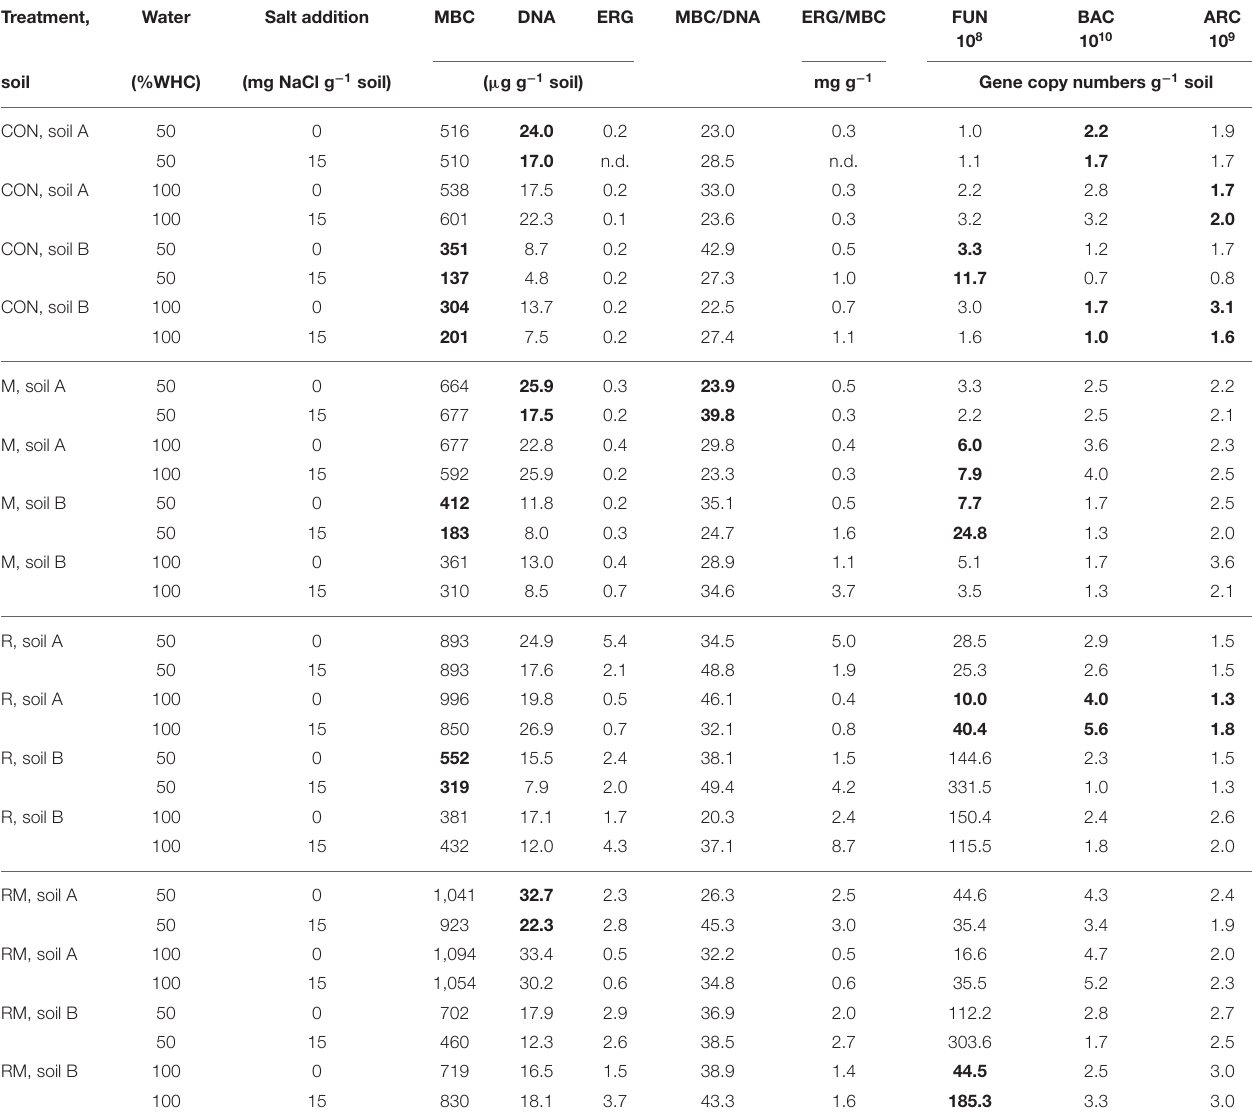
TABLE 2 | Microbial biomass C (MBC), total extractable DNA, ergosterol (ERG), the MBC/DNA ratio, the ERG/MBC ratio, fungal ITS1 sequences g − 1 soil (FUN), bacterial (BAC) and archaeal (ARC) 16S rRNA gene copies g − 1 soil in control (CON), manure (M), rice straw (R) and rice straw with manure (RM) amended soils. Treatment,